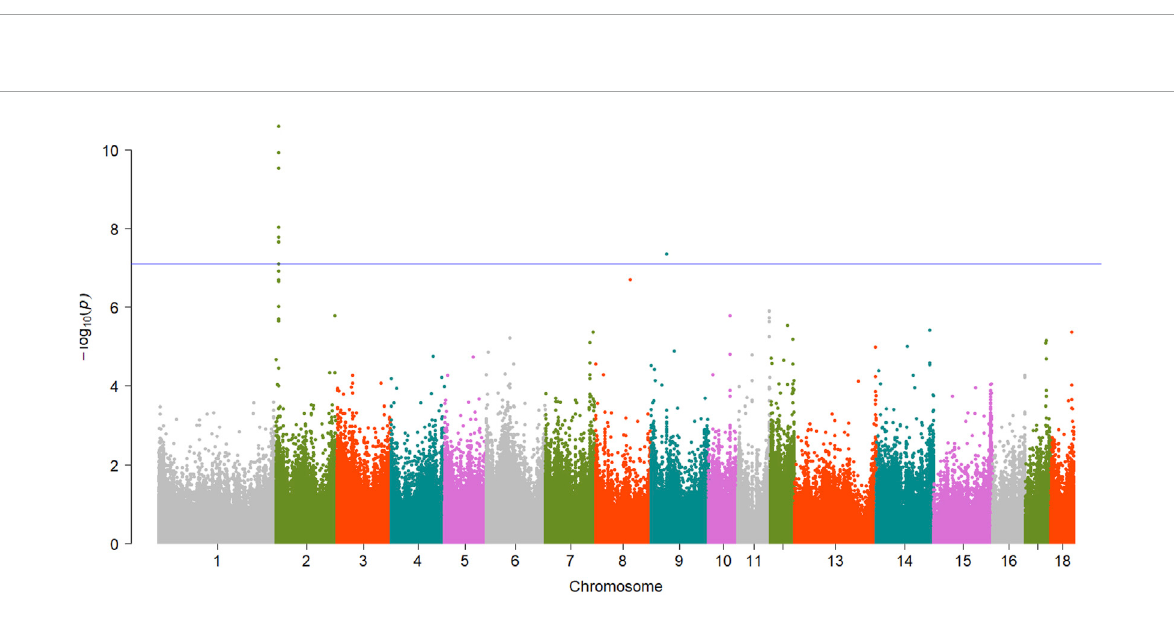
FIGURE 2 Manhattan plot showing EWAS results for DL trait. Each dot represents an CpG site and the blue line represents the